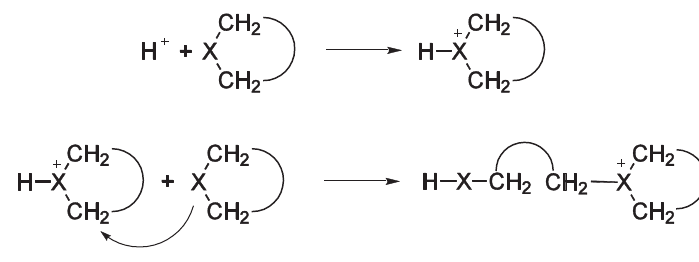
Figure 16. Initiation of a cationic ROP by a Brönsted